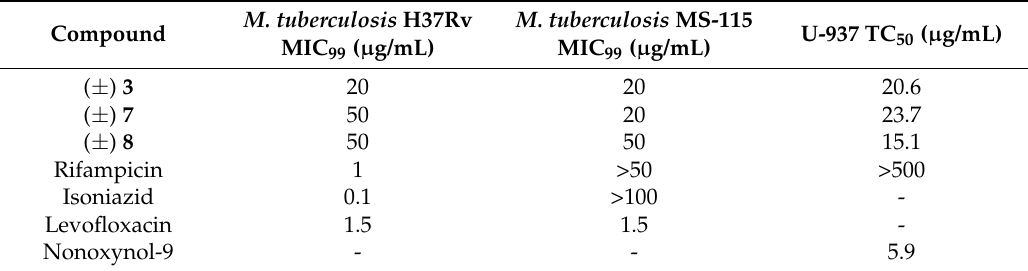
Table 2. The antimycobacterial activity * of 5 (cid:48) -norcarbocyclic derivatives of 5-substituted uracil and cytotoxicity to U937